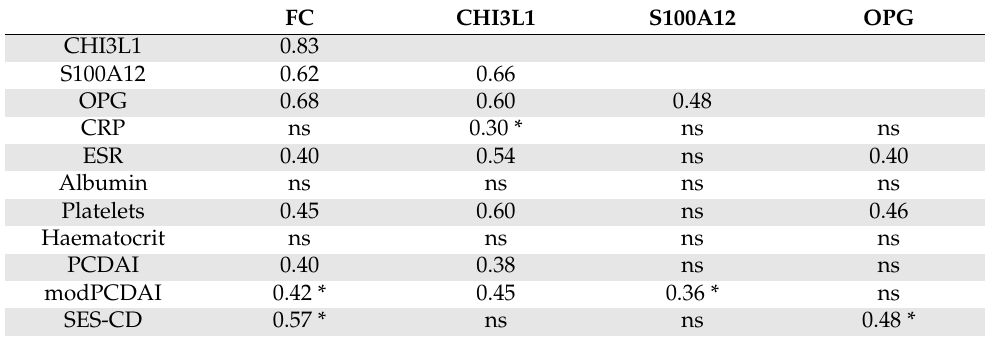
Table 3. Spearman’s rank correlation coefficients in children with Crohn’s disease. FC CHI3L1